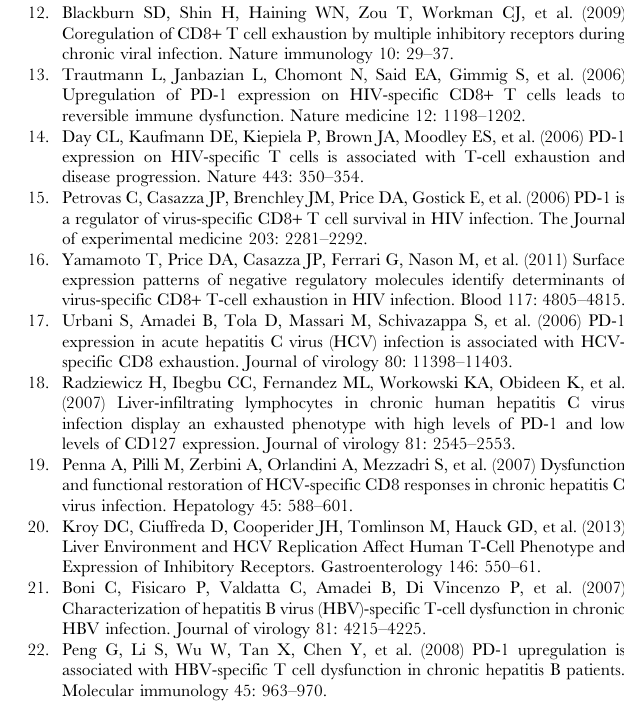
Figure S7 Relationship between the longitudinal ex- pression of T-bet/Eomes, inhibitory receptors and markers of immune activation. (A) Area-under-curve measurement (AUC) of PD-1 + CD160 + 2B4 + and T-bet dim Eomes hi expressing CD8 + T cells longitudinally post ART, followed by Spearman non-parametric test to test for significant correlation. (B) Correlation between the frequency of T-bet dim Eomes hi and CD38 + HLA-DR + expression on CD8 + T cells before ART initiation (Spearman non-parametric test). (C) Frequency of T- bet dim Eomes hi and PD-1 + CD160 + 2B4 + expressing CD8 + T cells between individuals with viral load . 40 copies/mL (n= 8; black) and , 40 copies/mL (n= 14; grey) 12–16 weeks post ART initiation. Mean and 95% CI are shown and based on the frequency of the markers after 12–16 weeks in comparison to baseline. Un-paired t-tests were performed to test for significance between the groups. Table S1 HIV RNA levels of longitudinal cohort. Viral load and CD4 count measurements of the HIV-infected cohort (n= 24) that was longitudinally followed after ART initiation for 5–7